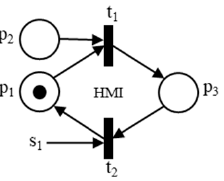
Figure 7. Model for the virtual element of command in the HMI.